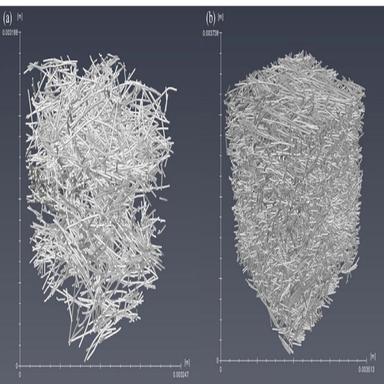
3D rendering of fibers with Avizo® (a) sample 406 at 3.5 μm/voxel (b) sample 409 at 3.5 μm/voxel.